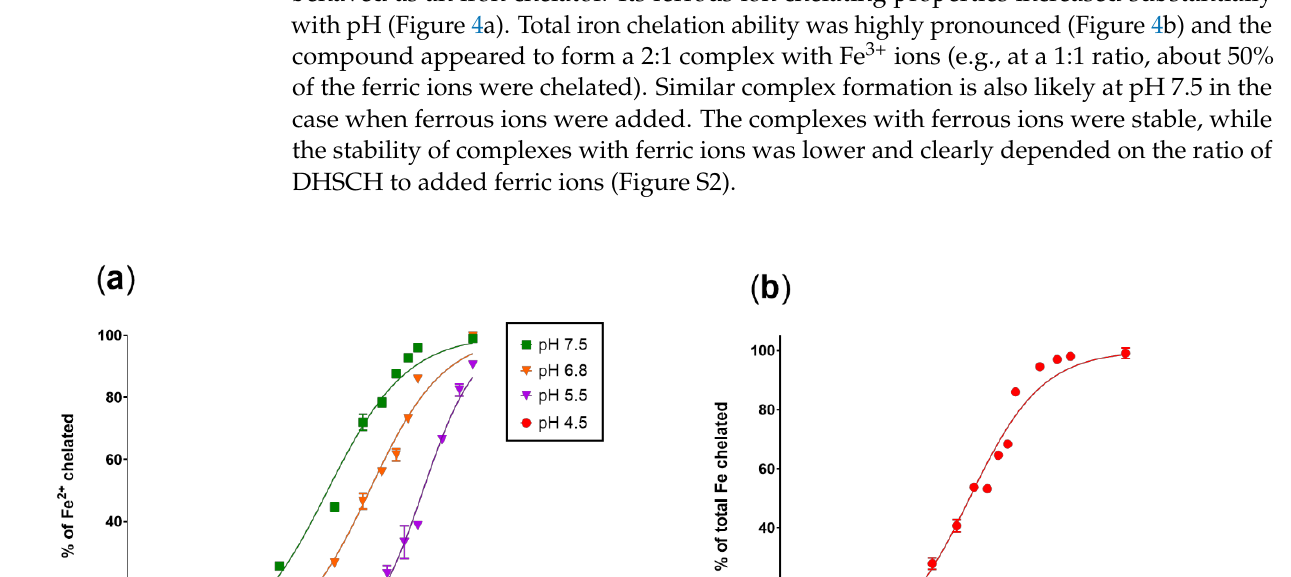
Figure 3. Chelation of copper ions by 2,3-dehydrosilychristin using the disodium bathocuproine disulfonate (BCS) method: ( a ) 2,3-dehydrosilychristin and cupric ions; ( b ) 2,3-dehydrosilychristin and cuprous ions. Data depict the meas- urement after 5 minutes.